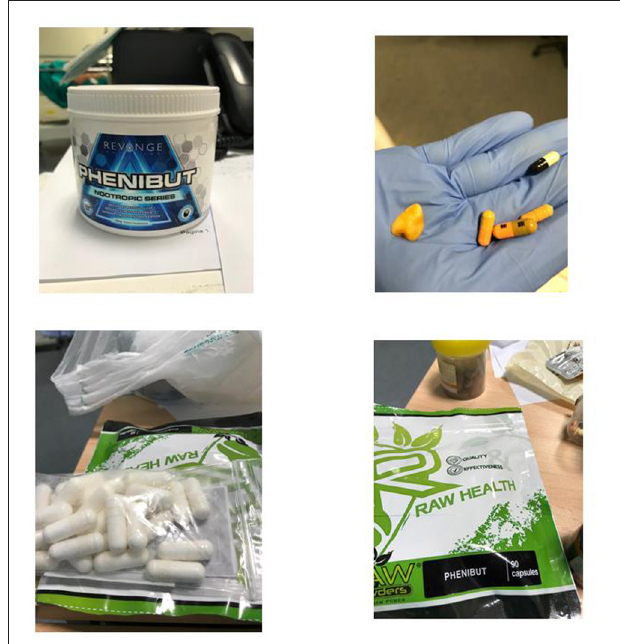
FIGURE 1 | Pictures of phenibut tablets in various commercial formulations (Fenibut, Anvifen, and Noofen) found at patient’s